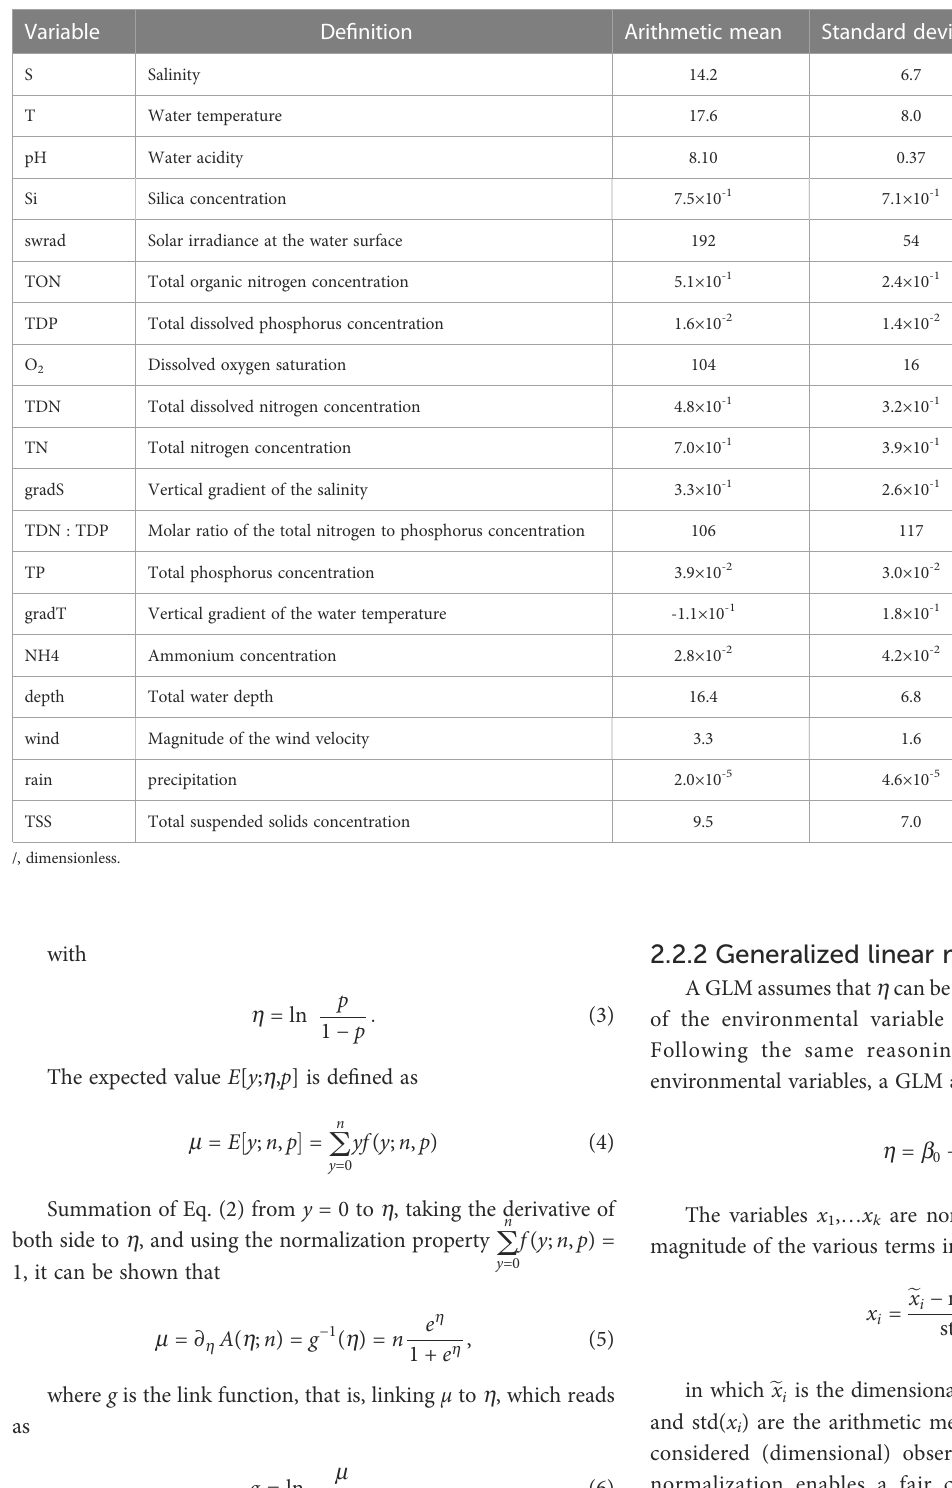
TABLE 1 The nineteen environmental variables used to train the P. minimum models and their mean and standard deviation observed at the surface (< 1 m) in the Chesapeake Bay between